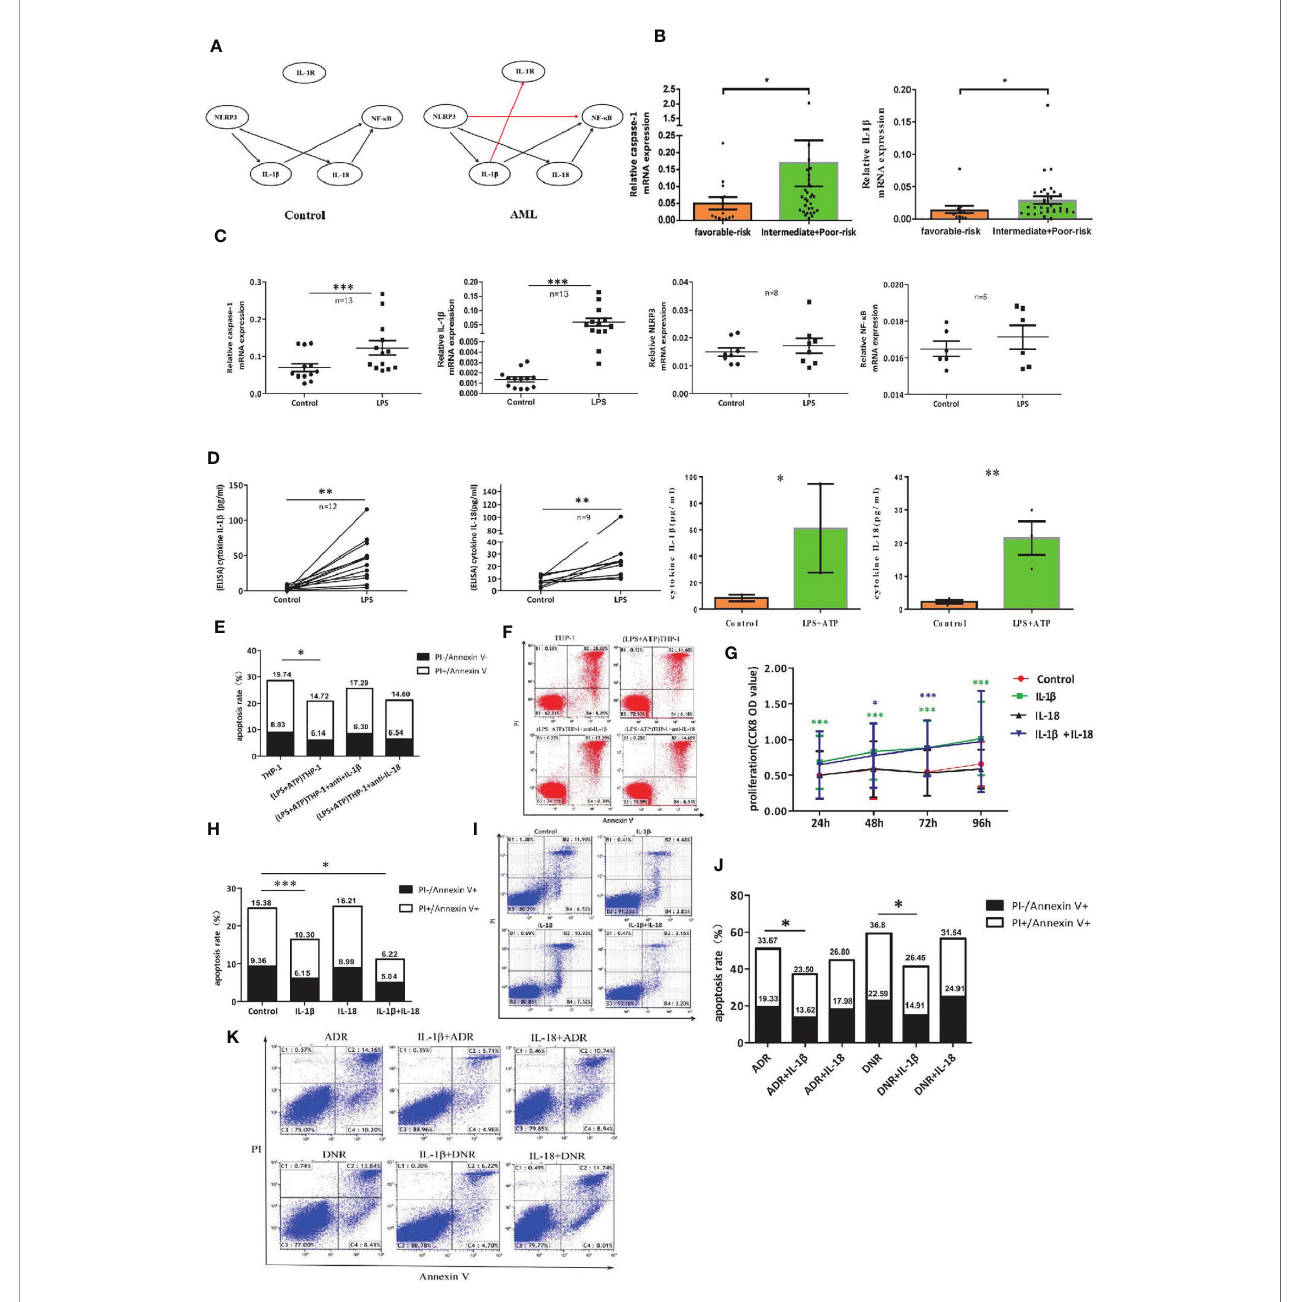
FIGURE 5 | The leukemia-promoting effect induced by NLRP3 activation acts through IL-1 b but not IL-18. (A) Bayesian network model diagram was designed according to qRT-PCR results of NLRP3 in fl ammasome in controls and ND AML patients. (B) The mRNA expressions of NLRP3 in fl ammasome components caspase-1 and IL-1 b in favorable (n=13) and intermediate/poor-risk (n=32) groups. (C) The mRNA expressions of NLRP3 in fl ammasome components caspase-1, IL-1 b , NLRP3 and NF- k B in THP-1 cells were compared before and after LPS stimulation. (D) The concentrations of IL-1 b and IL-18 in supernatants of cultured THP-1 cells following LPS or LPS+ATP treatment. (E) The apoptosis rate of primary leukemia cells after being co-cultured with LPS-activated THP1 cells with or without adding anti-IL-1 b or anti-IL-18 antibody (n=6). (F) Representative scatter plots of apoptosis. (G) CCK8 assay was applied to analyze the proliferation of primary leukemia cells after adding IL-1 b or/and IL-18 for 24, 48, 72 and 96 hours (n=21). (H) Flow cytometry analysis of Annexin V-FITC/PI-staining method was performed to analyze apoptosis of primary leukemia cells after adding IL-1 b or/and IL-18 for 48 hours (n=24). (I) Results were plotted as the percentage of cells in each quadrant. (J) Cell apoptosis was analyzed by fl ow cytometry 48 hours after adding ADR (200 m g/L) or DNR (20 m g/L) with or without IL-1 b or IL-18 (n=8). (K) Representative scatter plots of fl ow cytometry. *P < 0.05; **P < 0.01; ***P <